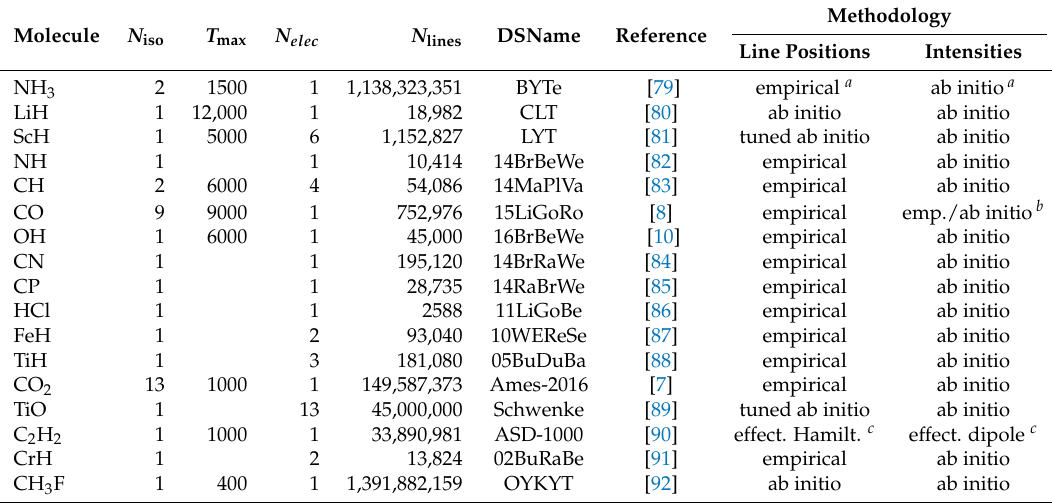
Table 3. Other molecular line lists considered. These data can also be obtained from the ExoMol website.